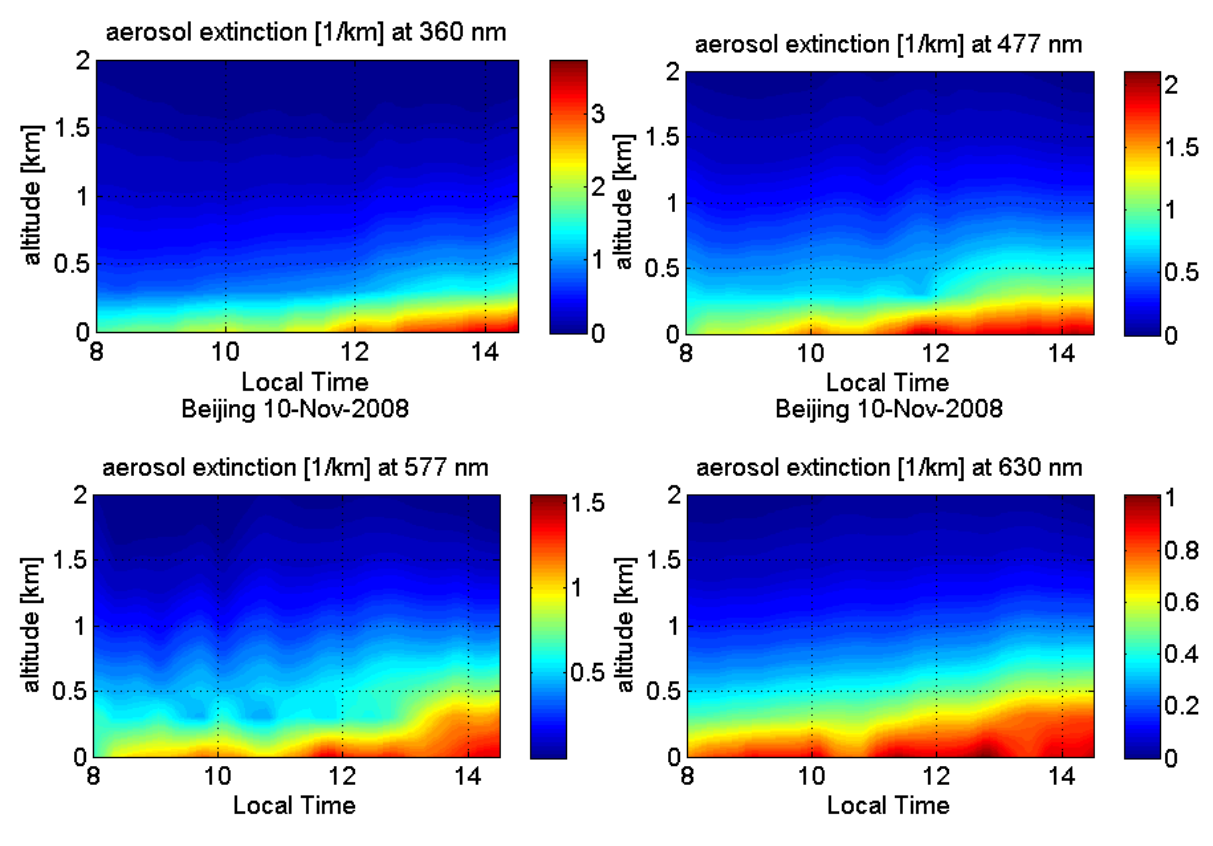
Fig. 10. Diurnal variation of retrieved aerosol extinction profiles on 10 November 2008 in Beijing, shown as contour plots for 360, 477, 577, and 630nm. Table 2. Linear regression fit parameters (slope and offset) and statistical parameters (correlation coefficient R , bias, standard deviation (stdev), number of points ( N )) for the comparison of the total AODs retrieved from the corrected O 4 DSCDs and the values from a sunpho- tometer in